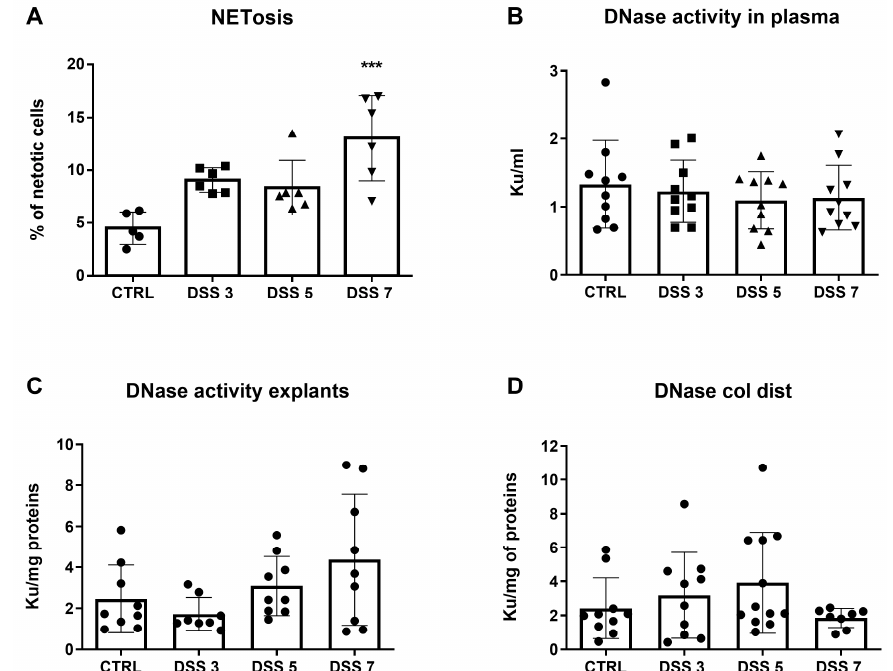
Figure 2. Neutrophil extracellular trap (NET) osis and deoxyribonuclease (DNase) activity. ( A ) percentage of cells undergoing NETosis was elevated in both DSS 3 and DSS 5 groups compared to control group, however the highest percentage was observed in DSS 7 group. ( B ) DNase activity in plasma did not differ between the groups. ( C ) DNase activity in explants showed a rising trend along with increasing disease severity. ( D ) DNase activity in the distal colon was the highest on day 5, however decreased on day 7. *** = p < 0.001.